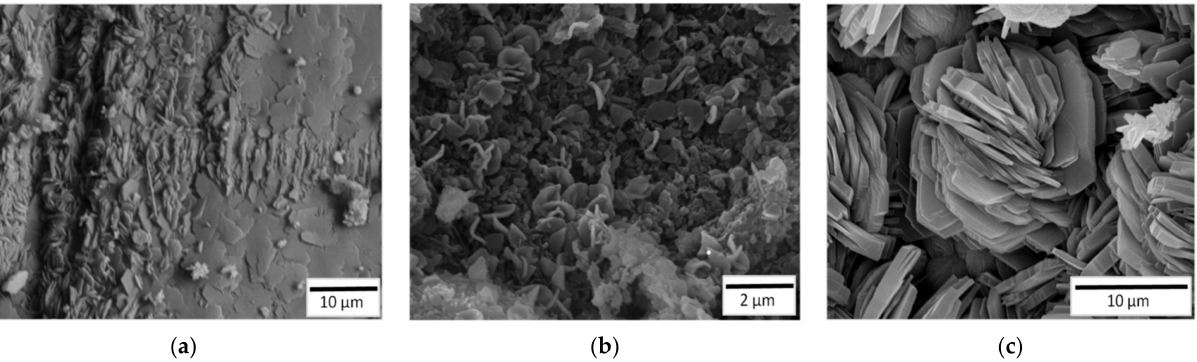
Figure 12. SEM images: hexagonal plates of kaolinite on Si-Al biofilm ( a ), haphazardly oriented kaolinite ( b ), and kaolinite roses on Si-Al biofilm ( c